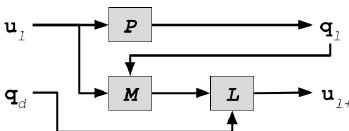
Figure 1. Iterative learning control scheme. eration number, N represents the total number of iterations, u l represents control law’s the feed-forward term for itera- tion l , q denotes the output trajectory for iteration l , and l q represents the desired output trajectory. After each itera- d tion, the feed-forward term u l + 1 is computed offline and is used to reduce the trajectory tracking error for iteration l + 1.